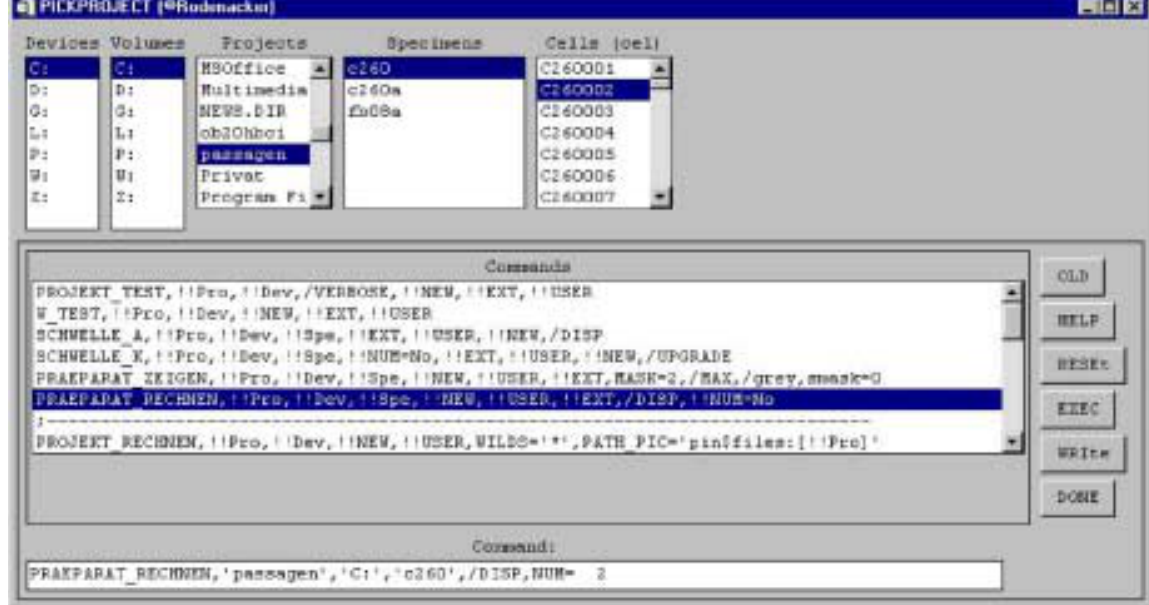
Fig. 14. Graphical user interface (GUI) for image cyto- and histometry. Selection of volume, project and specimen, eventually image with possible commands and editable execution line. This figure can be viewed on